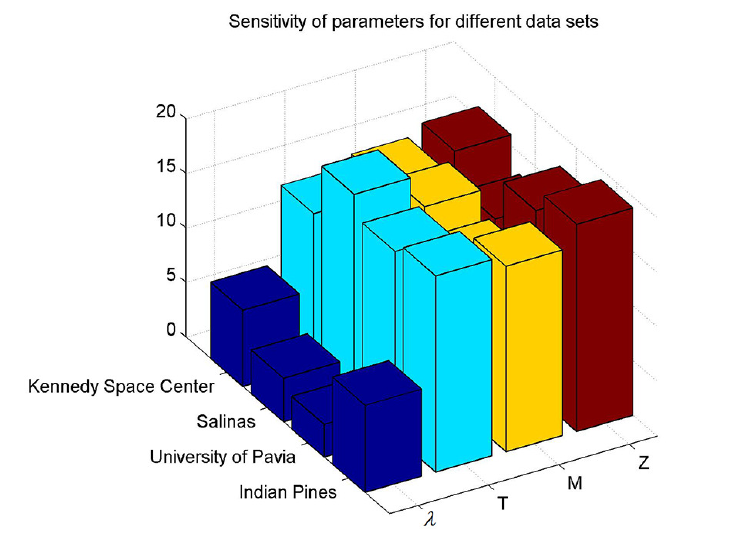
Figure 9. Sensitivity of the parameters for different data